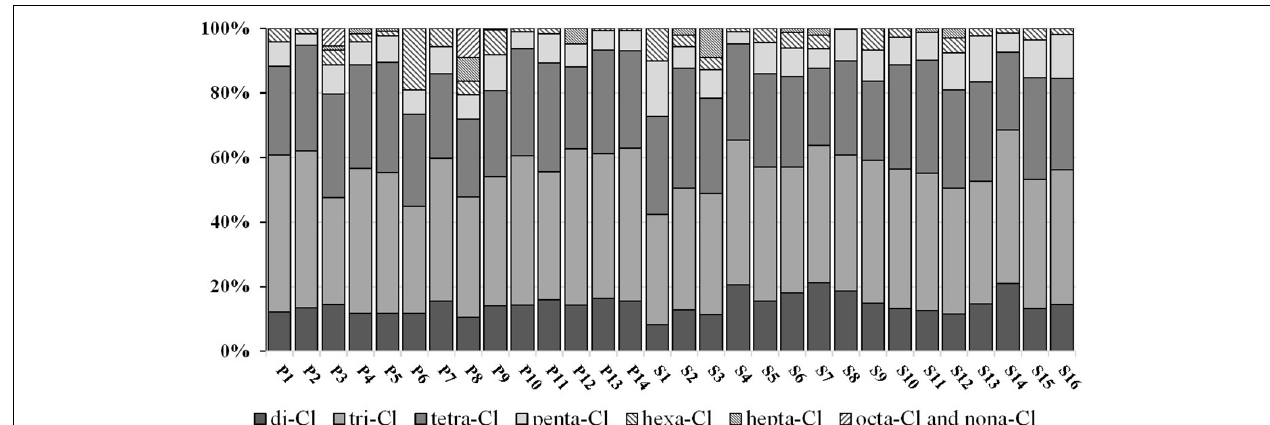
FIGURE 4 | PCB homolog compositions in the surface sediments of Qingduizi Bay.